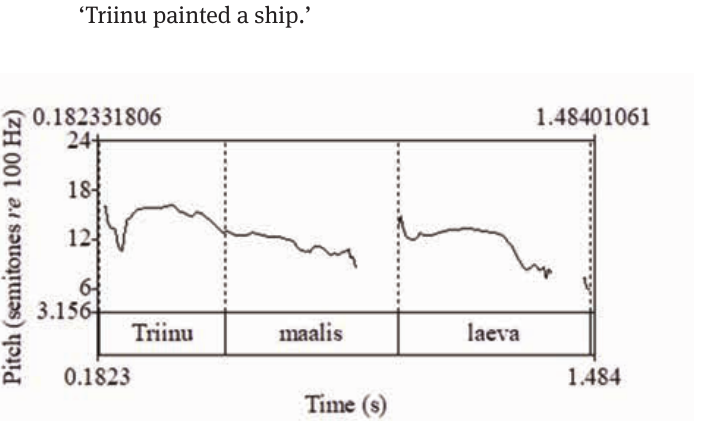
Figure 3: The pitch contour of the sentence in (12), produced in a broad focus context (from Sahkai and Veismann